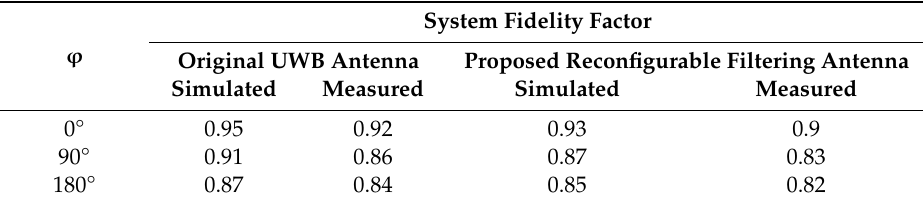
Figure 12. The calculated pulse shapes at the passive antenna output from measurement at various ϕ : ( a ) ϕ = 0 ◦ , ( b ) ϕ = 90 ◦ , and ( c ) ϕ = 180 ◦ . Table 4. System fidelity factor for the UWB monopole antenna and the proposed antenna.